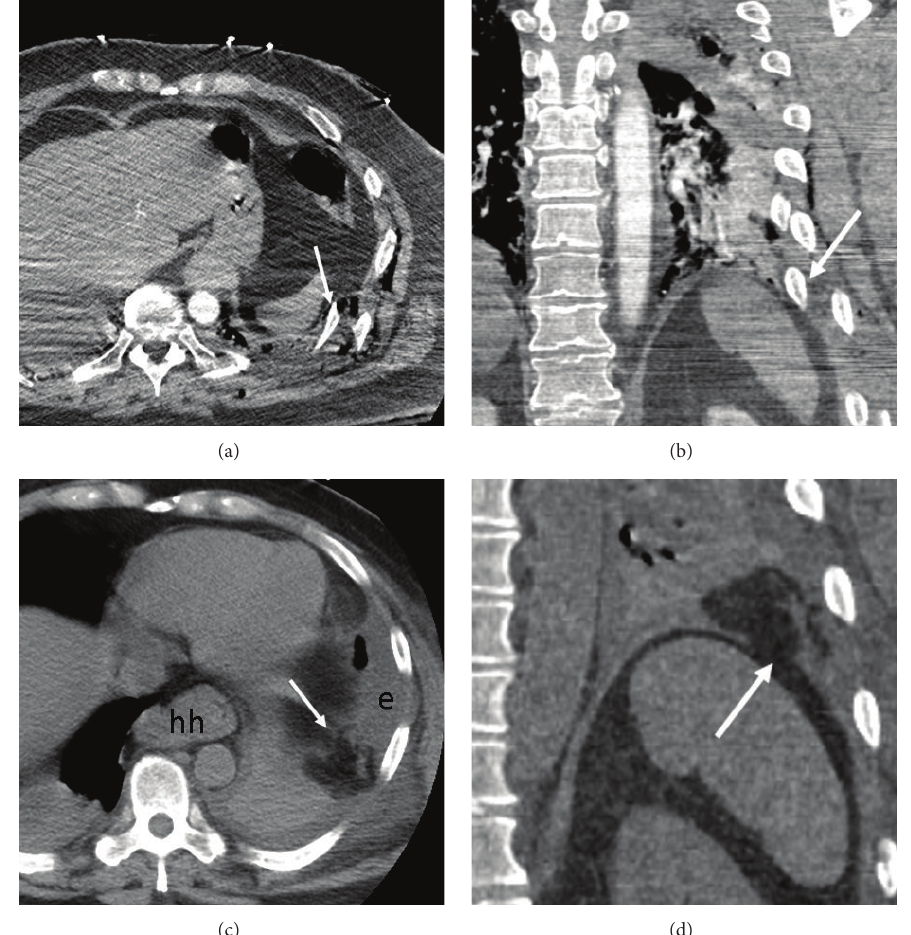
Figure2:Fracturedribsignina64-year-oldmanafterblunttrauma.(a,b)Contrast-enhancedtraumachestMDCT(axialandcoronalplanes) shows displaced left lower rib fractures abutting left diaphragm (arrows). The diaphragm appears intact. A small hiatal hernia is present (hh). (c, d) Repeat MDCT 4 days later (axial and coronal planes) shows new herniated omental fat (arrows) within left hemithorax due to subacute diaphragm rupture. Note discontinuity of the diaphragm (d). The large left effusion (e) is